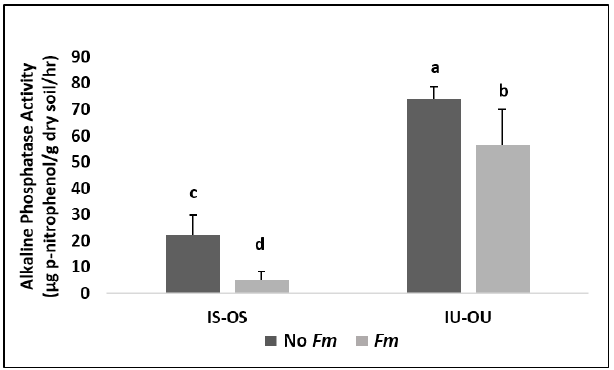
Figure 5. Potential soil alkaline phosphatase (ALP) activity in the hyphosphere soils. IS-OS: soil in inner (hyphosphere) and outer (rhizosphere) compartments sterilized; IU-OU: both soils unsterilized. “ Fm ”: inoculated with Funneliformis mosseae . Data presented are mean with ± standard deviation ( n = 3). Different letters above the bars indicate significant difference between the treatments ( p < 0.05).